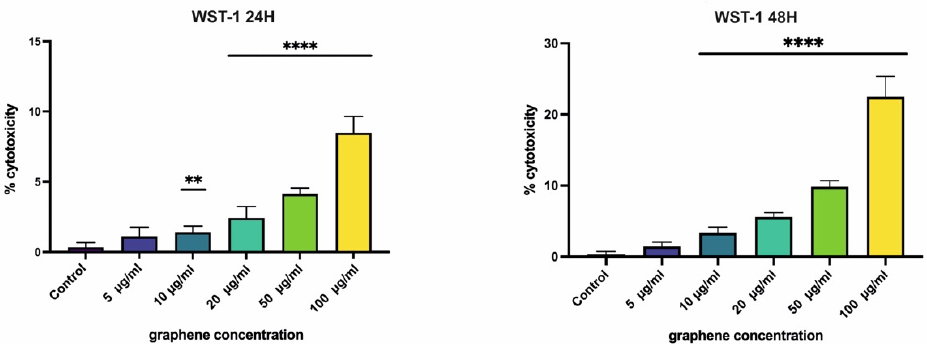
Figure 1. Cytotoxicity of nanomaterials determined by WST-1 analysis. The cytotoxicity level increased with longer exposure to the GPs. Data are presented as a percentage (%) of untreated control (0 μ g/mL) and are visualized as mean ± standard deviation. ** p -value < 0.01; **** p -value < 0.0001.